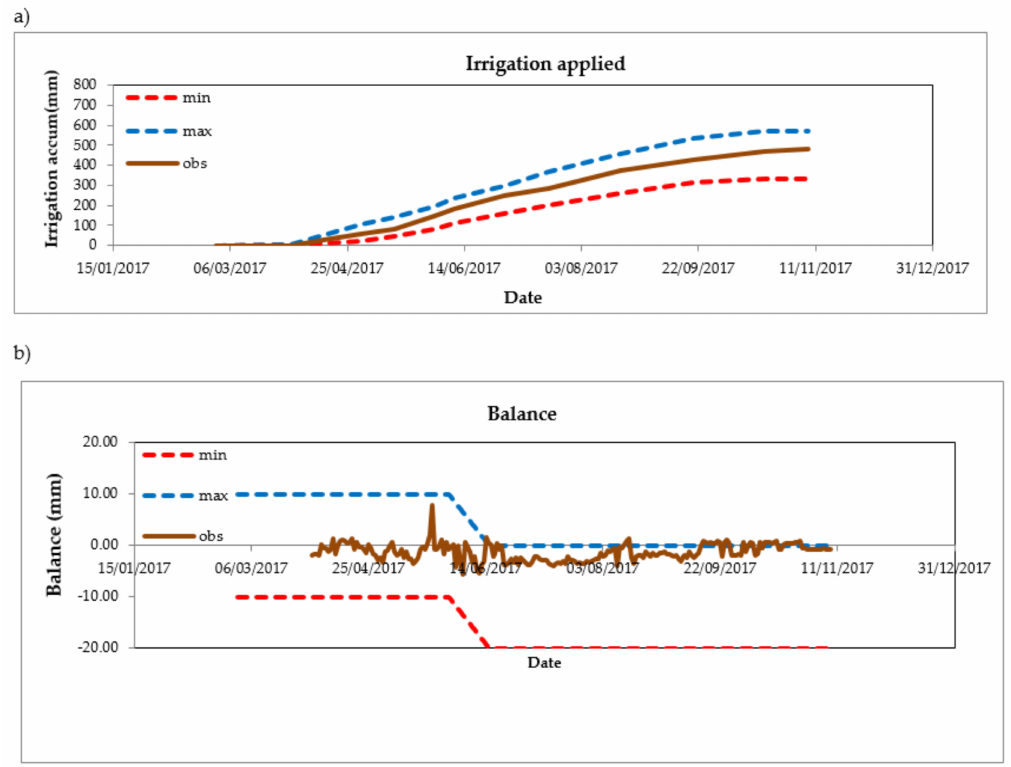
Figure 5. Screenshot of the ‘control plan’ tab of IRRIX in the year 2017, ( a ) the accumulated irrigation of treatment A during the irrigation campaign and ( b ) the water balance of treatment A during the irrigation